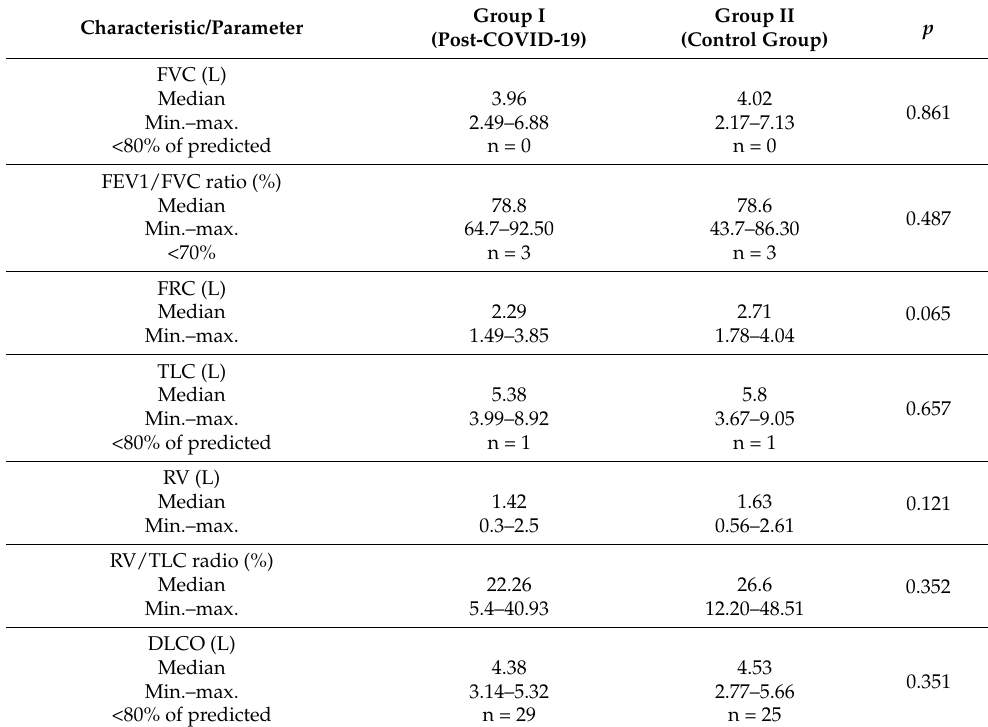
BMI = body mass index. WBC = white blood cell count. Lymphocyte = lymphocyte count. Neutrophil = neutrophil count. Monocyte = monocyte count. RBC = red blood cell count. HGB = hemoglobin. CREA =